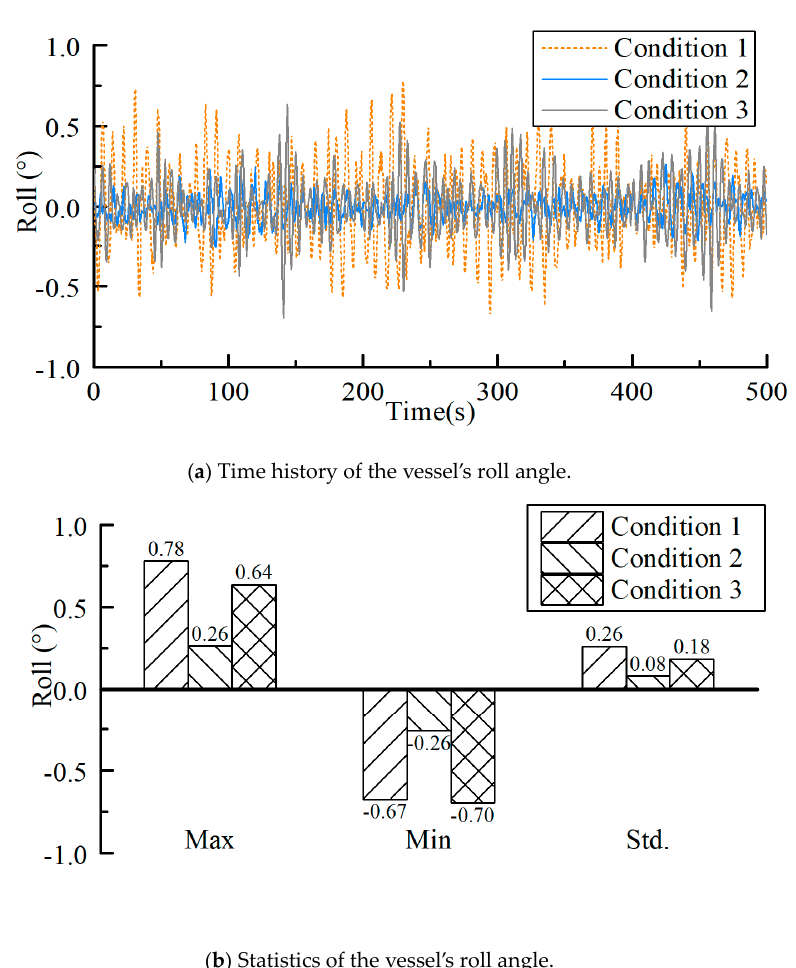
Figure 9. The time history and statistics of the vessel’s roll angle.